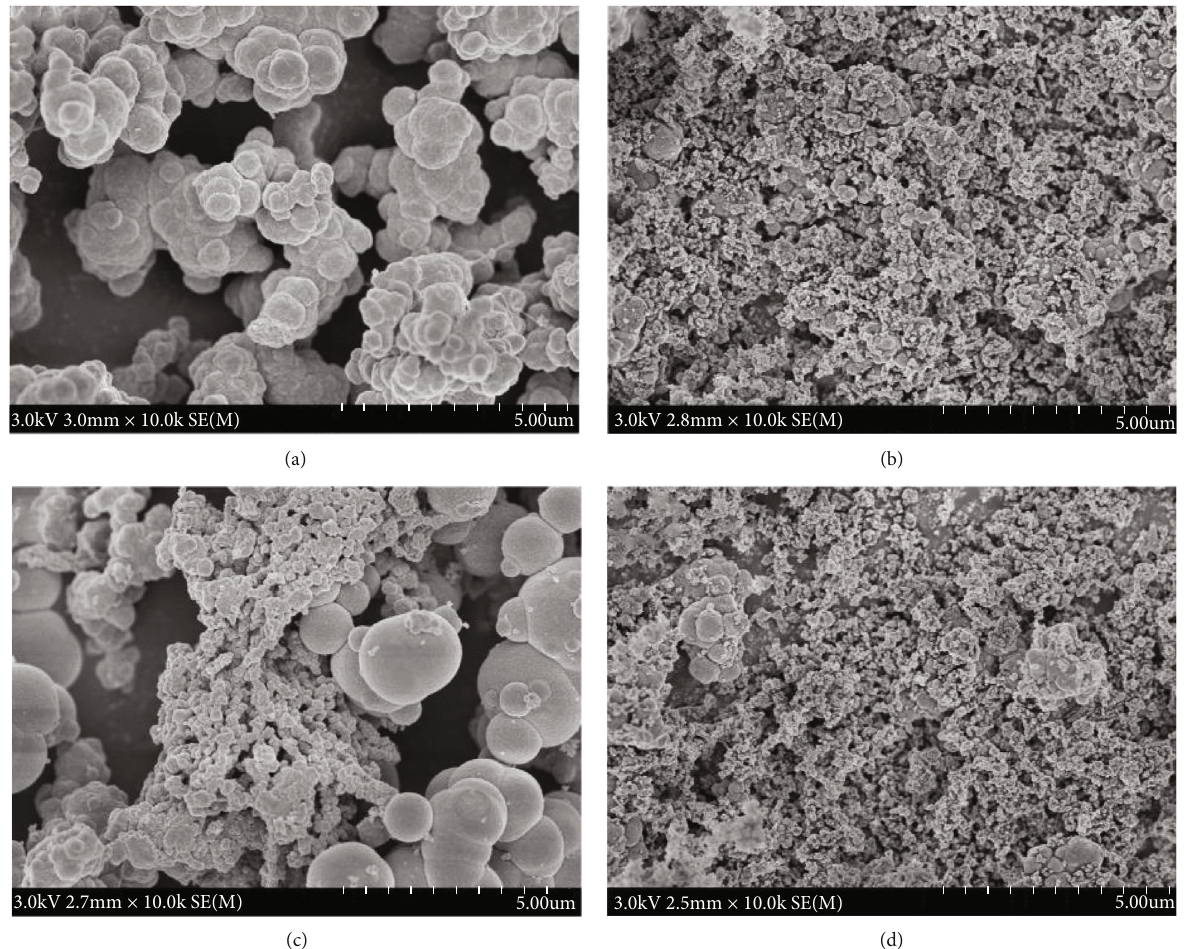
Figure 6: SEM images of (a) Blank-, (b) MEA-, (c) DEA-, and (d) TEA-CeO calcination in